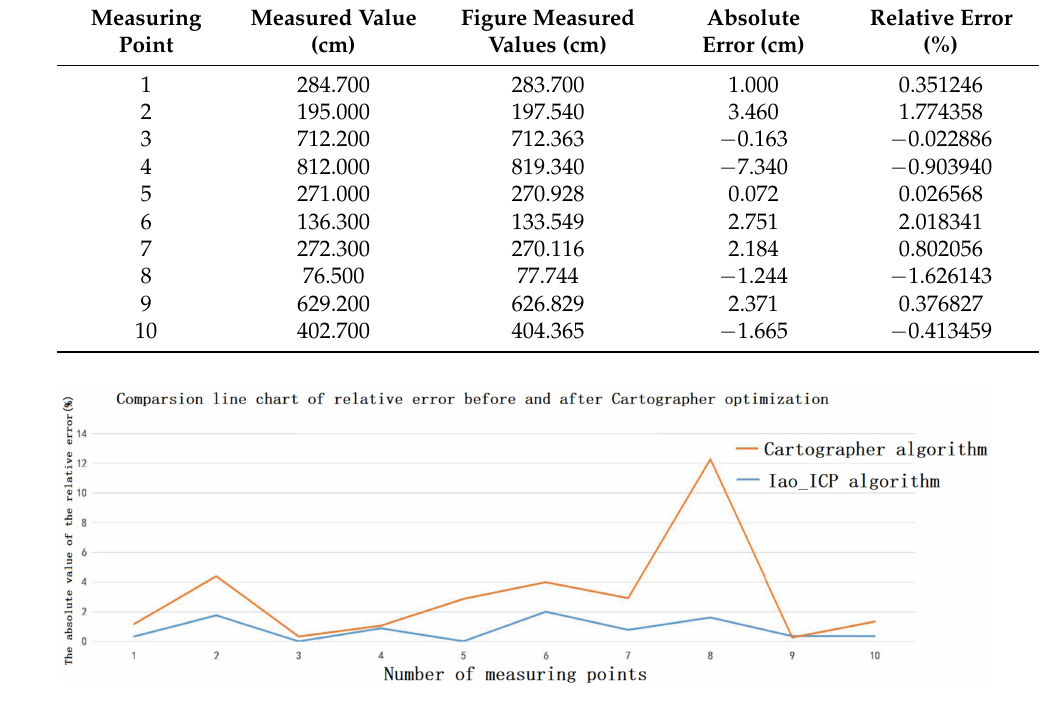
Figure 15. Line chart of relative error comparison of two